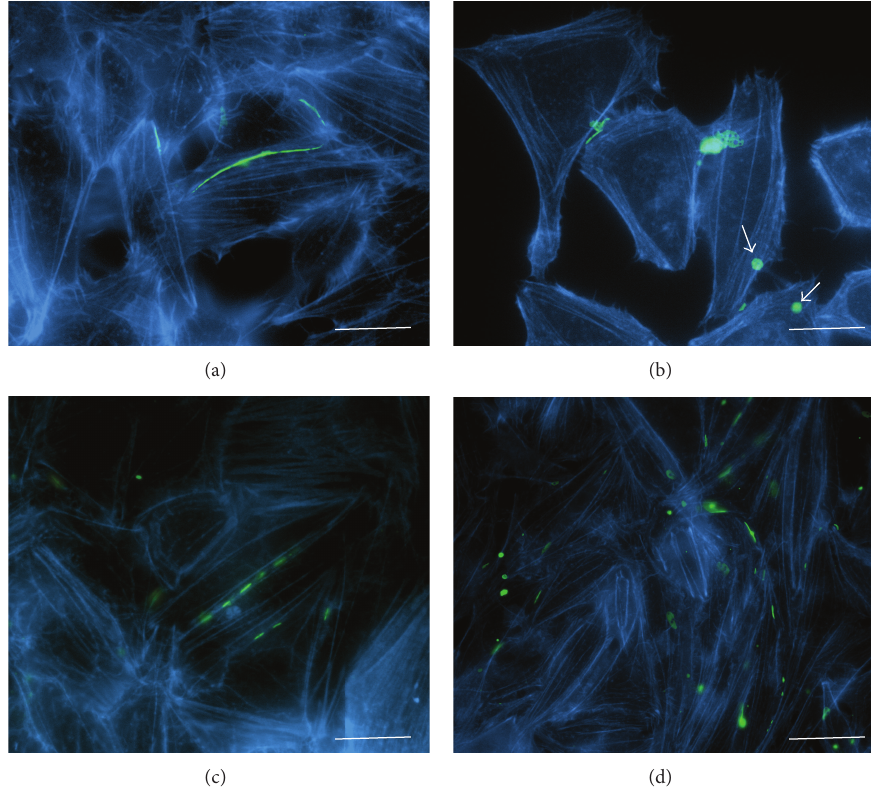
Figure 8: Impact of hyperthermia on actin filament organization in HeLa cells expressing Cx43-EGFP under control conditions (a); after hyperthermia (6h at 42 ∘ C) (b); under control conditions with XG-102 (4 𝜇 M) (c); after hyperthermia (6h at 42 ∘ C) with XG-102 (4 𝜇 M) (d). Blue: F-actin labeled with Alexa Fluor 594 phalloidin; green: Cx43-EGFP; white arrows indicate annular junctions containing internalized GJ plaques. Scale bar 25 𝜇